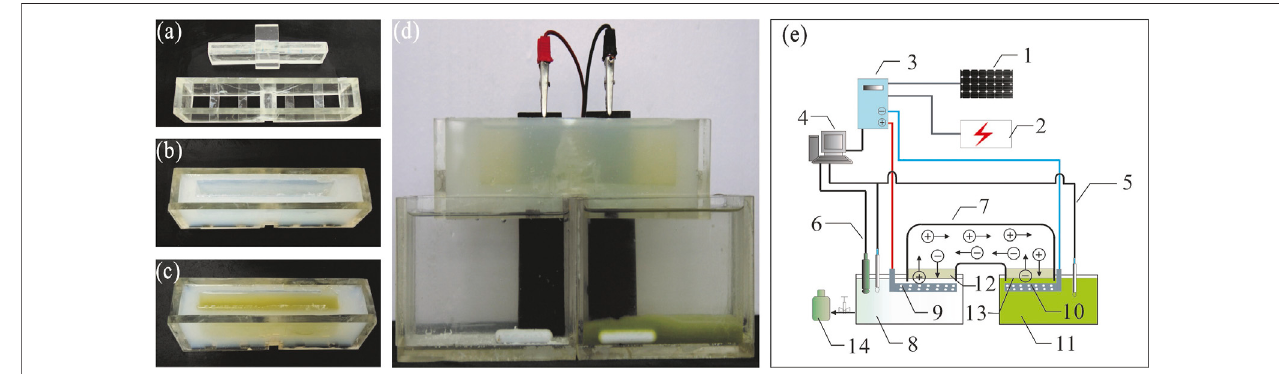
FIGURE1| Schematicofsalt-bridgeelectro fl occulation(SBEF)forharvesting N.oculata : (A – C) toolstoshapethesalt-bridge; (D) applySBEFtoharvest N.oculata (stay for 20 min when fi nished); (E) a conceptual design for SBEF coupling solar cells. Legends in Figure 1E : 1, solar cells; 2, public power network; 3, regulator; 4, computer;5,pHmeters;6,activechlorinemeters;7,salt-bridge;8,anodechamber;9,anode;10,cathode;11,algaepond;12,agarlayeroranodemembrane;13,agar layer or cathode membrane; and 14,